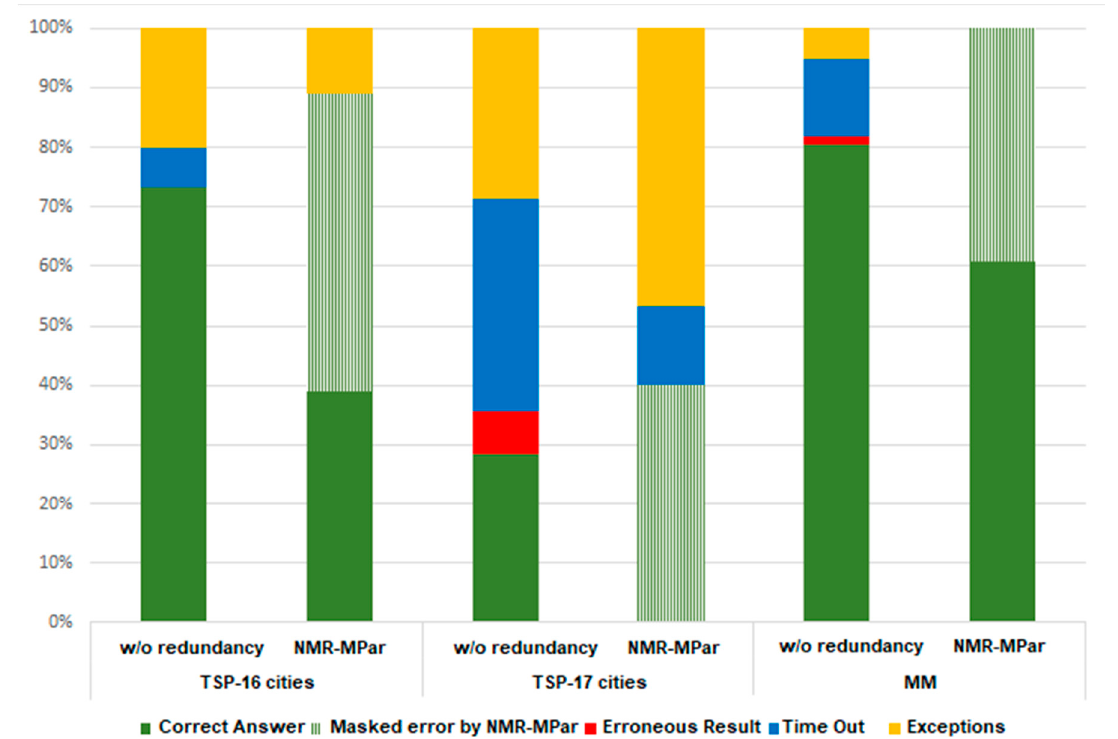
Figure 6. Comparison of the consequences of the evaluated applications.